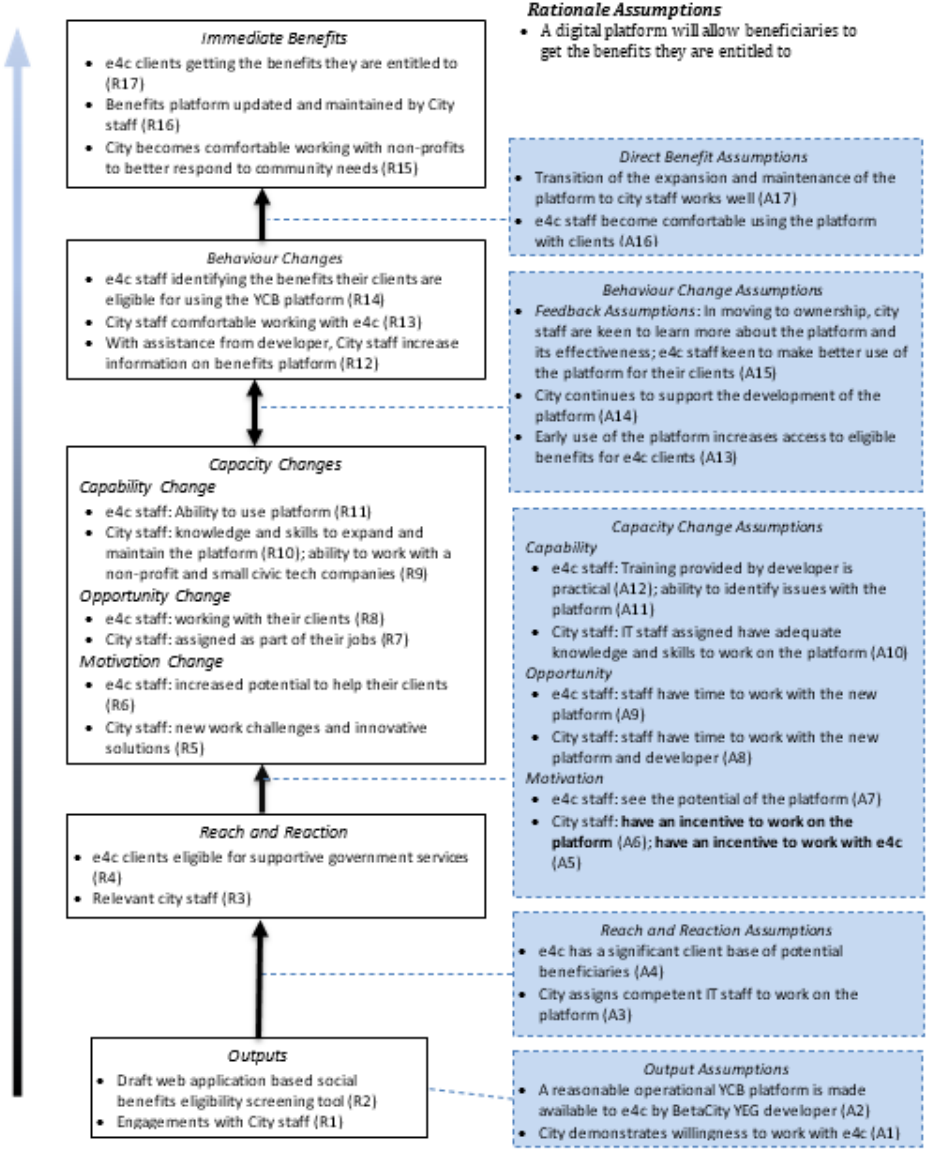
Figure 7: BetaCity YEG Theory of Change (“YouCanBenefit” Theory of